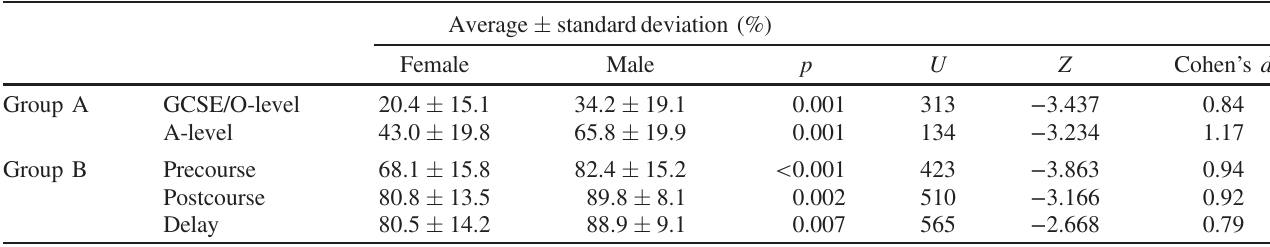
TABLE I. Average scores for each group split by gender. Comparisons were conducted using an independent samples Mann-Whitney test and a statistically significant difference was found in all cases. A power analysis indicated that all comparisons were sufficiently powered (GCSE ¼ 0 . 927 , A level ¼ 0 . 971 and 0.981, 0.976, and 0.923 for precourse, postcourse, and delay,